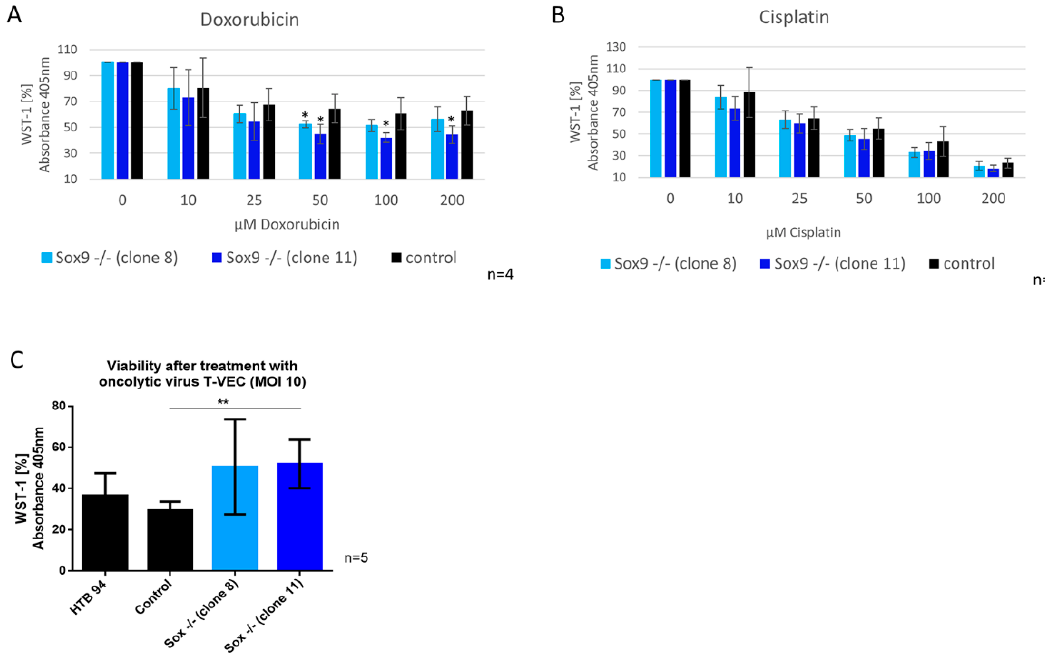
Figure 6. Viability of the SOX9 knockdown and knockout cells after doxorubicin and oncolytic virus treatment. ( A ) Increased sensitivity against doxorubicin after SOX9 knockout (50, 100, 200 µM dx), but not against cisplatin ( B ). ( C ) Decreased sensitivity against oncolytic virus (T-VEC) treatment after SOX9 knockout. Results are the means ± SD; * p ≤ 0.05; ** p ≤ 0.01; MOI = multiplicity of infection